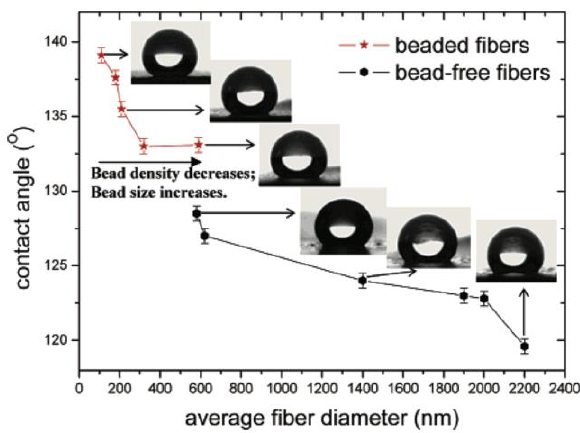
Figure 14. Contact angles for the as-spun poly(caprolactone) PCL mats. From bottom to top in the inset are representative droplet images on samples F1, F4, F6, B1, B3, and B5. The contact angles are 119°, 124°, 129°, 133°, 135°, and 139°, respectively. Reproduced with permission from [99].